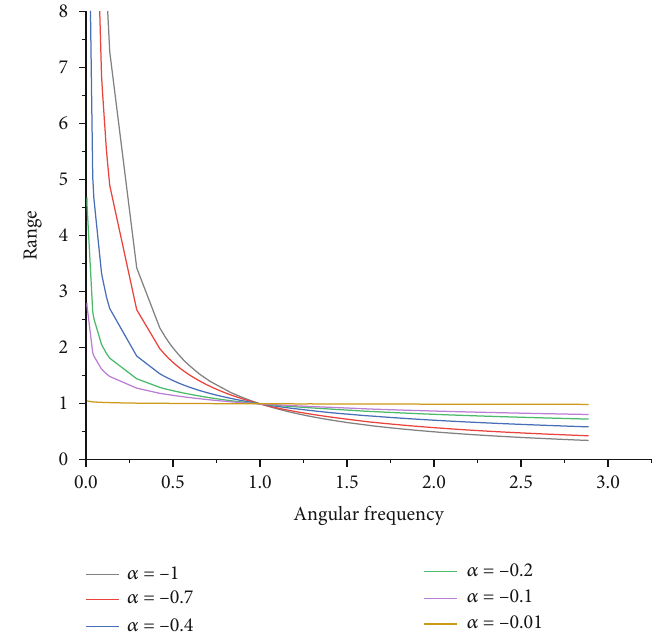
Figure 2: Magnitude-frequency characteristic curve of fractional-order integration.